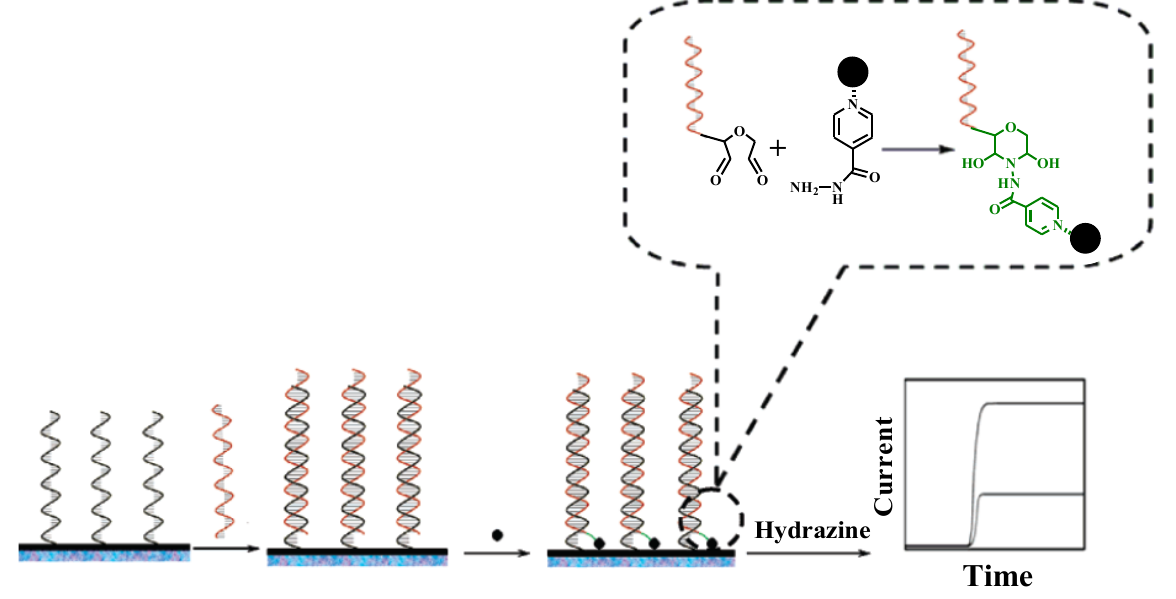
nanoparticles. 2